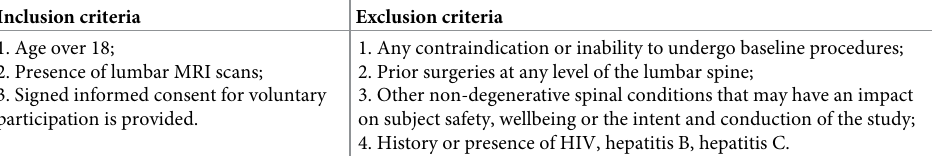
Table 2. Eligibility